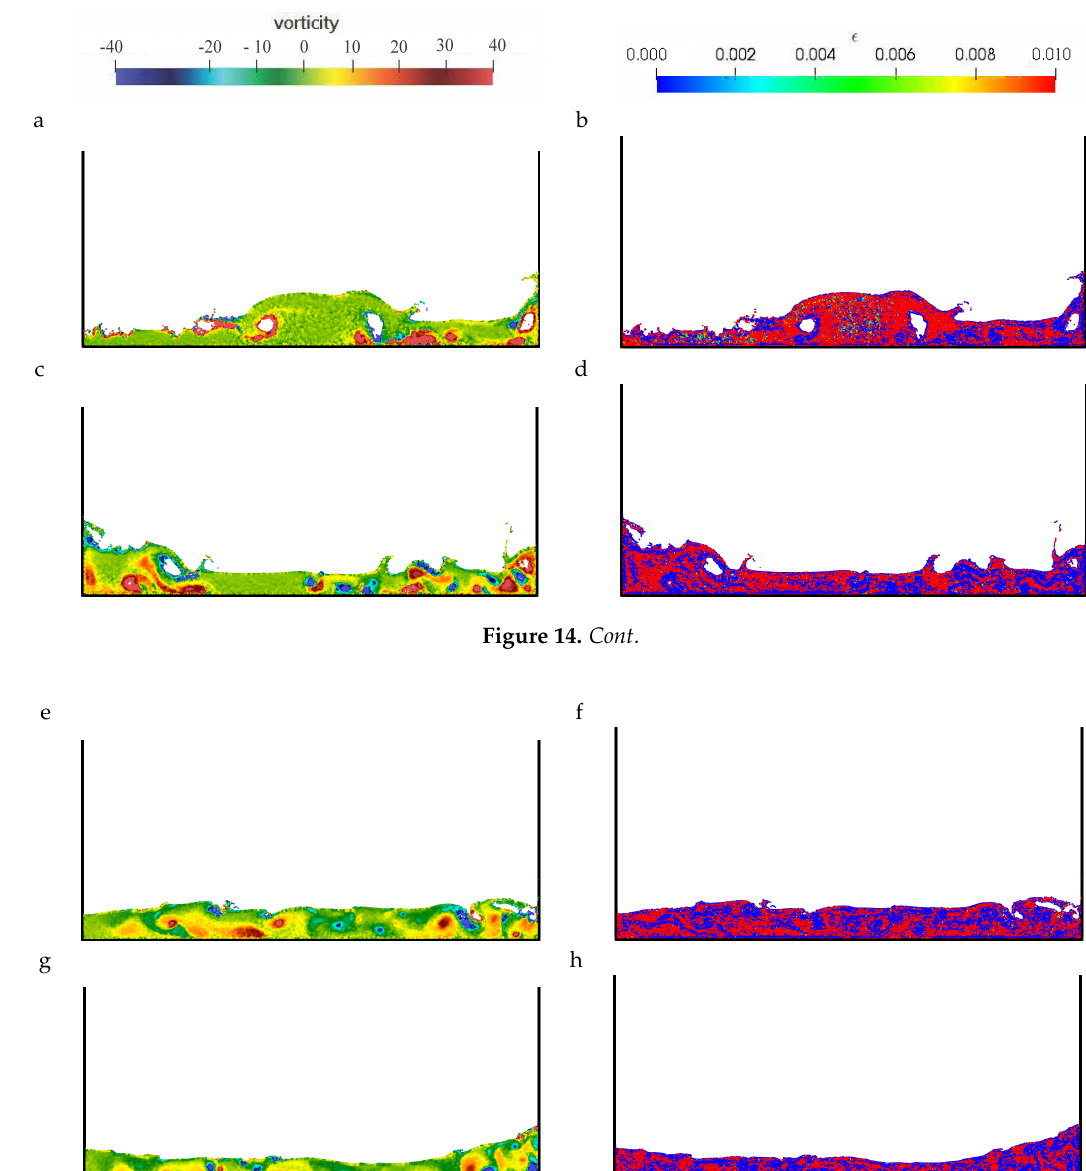
Figure 14. Two-dimensional dam-break flow: Snapshots of the computational results for different times (cid:112) t g / H with H / ∆ x 0 = 120. On the left column the vorticity field is presented, (cid:101) field is placed on the right. (cid:112) g / H = 9.54, ( c , d ) show the results at t Figures ( a , b ) show the results for t (cid:112) g / H = 19.09 and ( g , h ) shows the results obtained at t plots the results for t